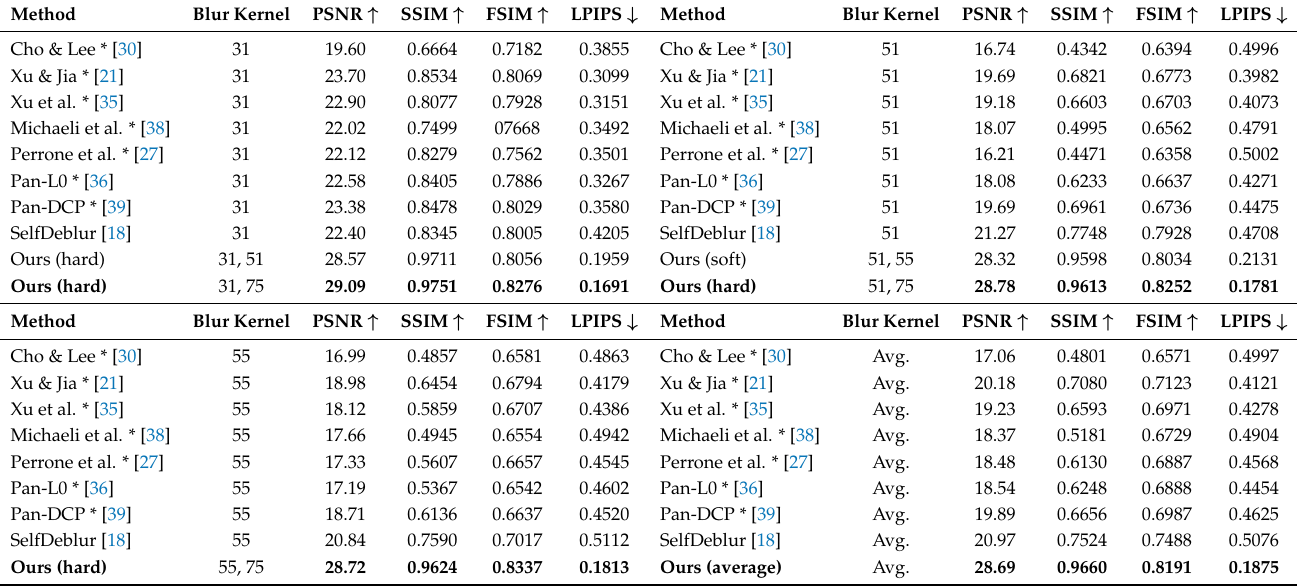
Table 6. Quantitative comparisons on the Lai test set [45]. The methods marked with * adopt [31,47] as non-blind deconvolution for the final result after kernel estimation. Ref. [47] is adopted as a non-blind deconvolution method in the Saturated category, and ref. [31] for the other categories. The best results are highlighted. Results of the blur kernel “Avg.” means the averagePSNR, SSIM, FSIM and LPIPS results for all blur kernels.